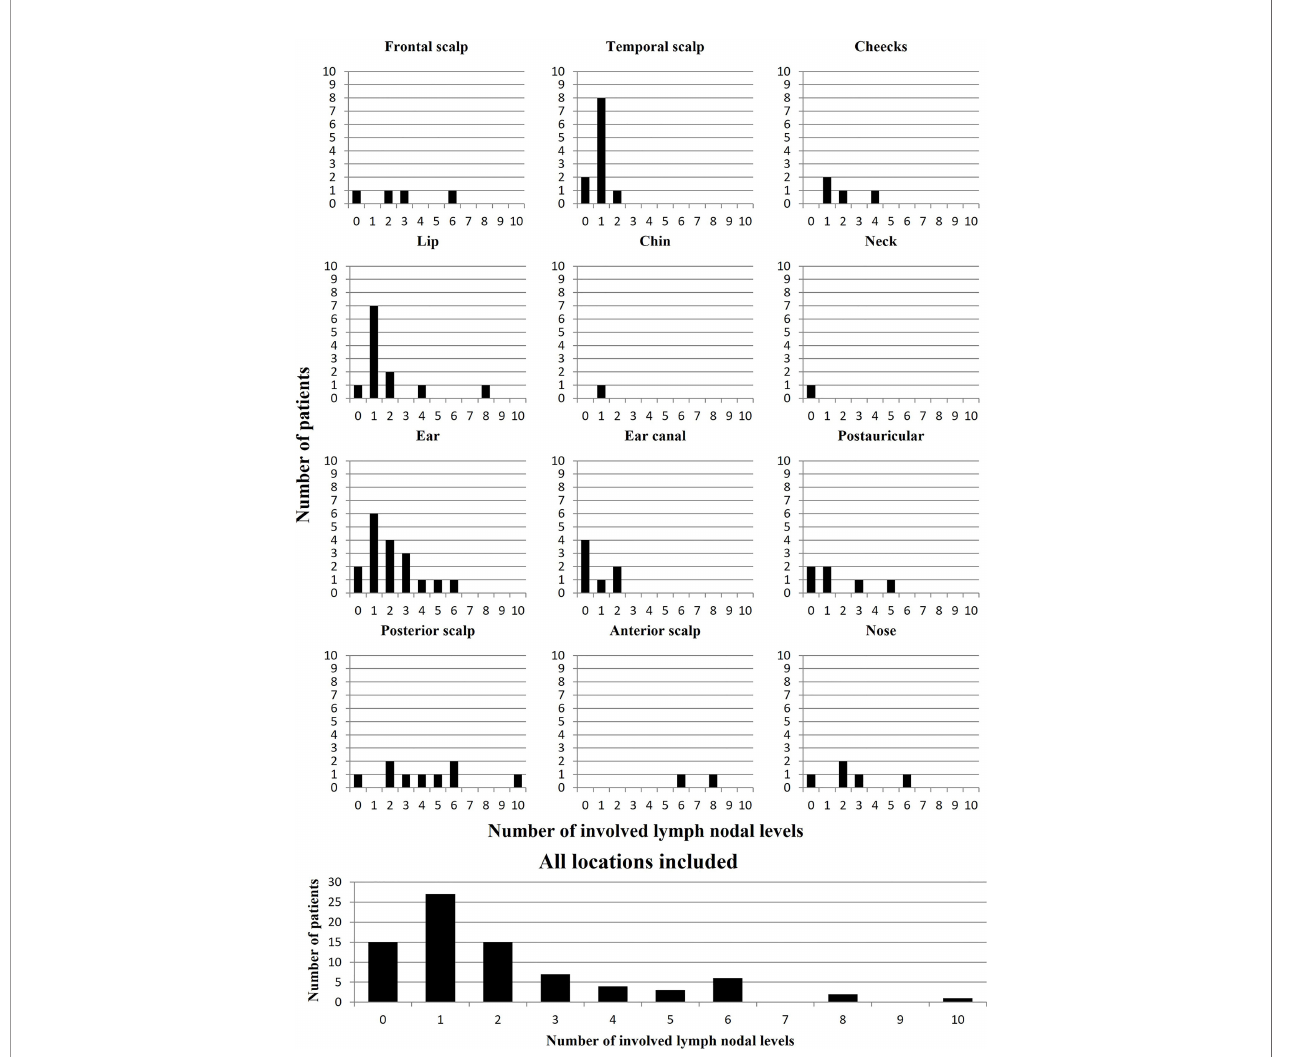
FIGURE 2 | Distribution fi gure of the total number of patients per total number of involved lymph nodal levels. Depicting the extent of the lymph nodal metastasis per primary tumor location, as well as for all locations together (i.e. tumors at the ear: 1 patient had no metastasis, 7 patients had 1 level involved, 2 had 2 levels involved, etc.) A maximum of 16 metastatic lymph node sites/levels could be involved (i.e. ipsi- and contralateral involvement of neck level I to V, the parotid gland, post-auricular and